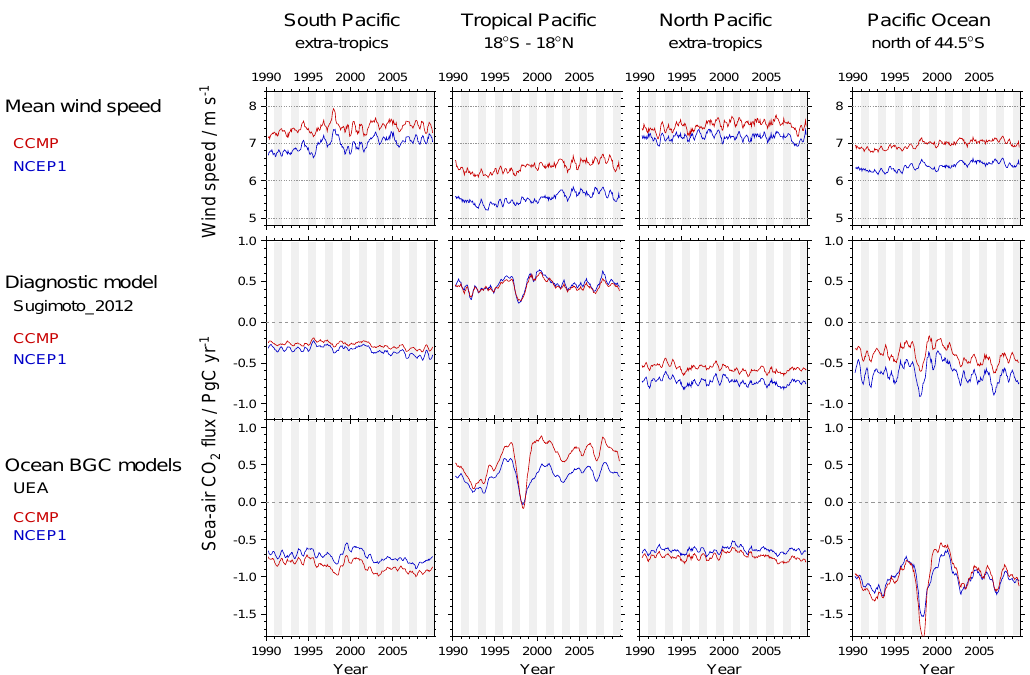
Fig. 12. Trend (5-month running means) of the monthly anomalies of wind speed of NCEP/NCAR Reanalysis 1 (NCEP1) (Kalnay et al., 2007) and Cross-Calibrated, Multi-Platform (CCMP) Ocean Surface Wind Product (http://podaac.jpl.nasa.gov/DATA_CATALOG/ccmpinfo. html) (Ardizzone et al., 2009; Atlas et al., 2011) (top), air–sea CO 2 flux for 1990–2009 calculated with the diagnostic model of Sugimoto et al. (2012) (middle), and with the ocean biogeochemistry/general circulation model of Buitenhuis et al. (2010) (bottom) using the surface wind fields of NCEP1 and CCMP in the South Pacific extratropics (45–18 ◦ S) (left), in the tropical Pacific (middle-left), in the North Pacific extratropics (18–66 ◦ N) (middle-right), and in the entire Pacific region shown in Fig.